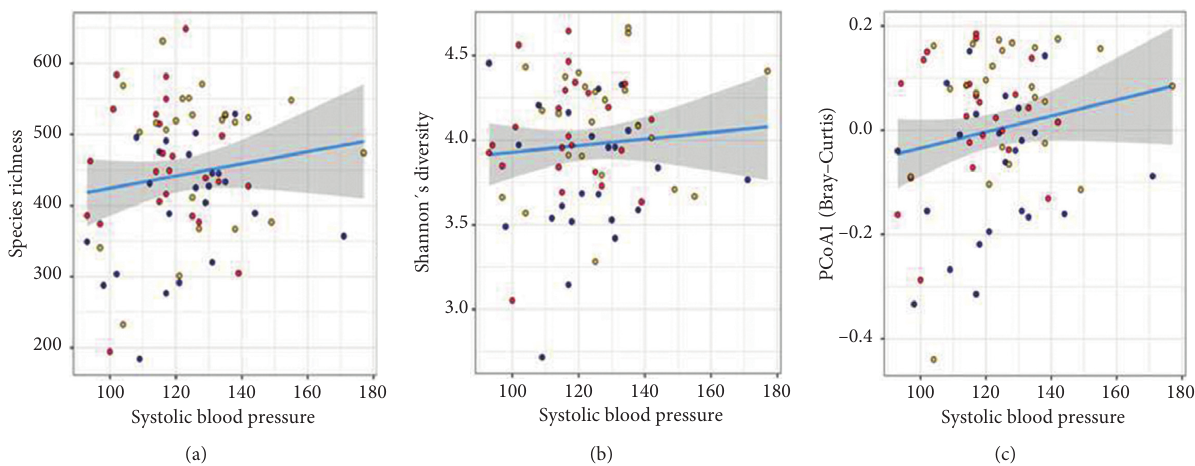
Figure 3: Gut microbial association with systolic blood pressure. A multivariate generalized linear mixed model (GLMM) was constructed to identify the association of gut microbe composition (random effect) with 15 host factors (fixed effect). Strong association was observed between systolic blood pressure and (a) species richness, (b) Shannon’s diversity, and (c) PCo1 using Bray–Curtis distance. The line is fitted linear model.